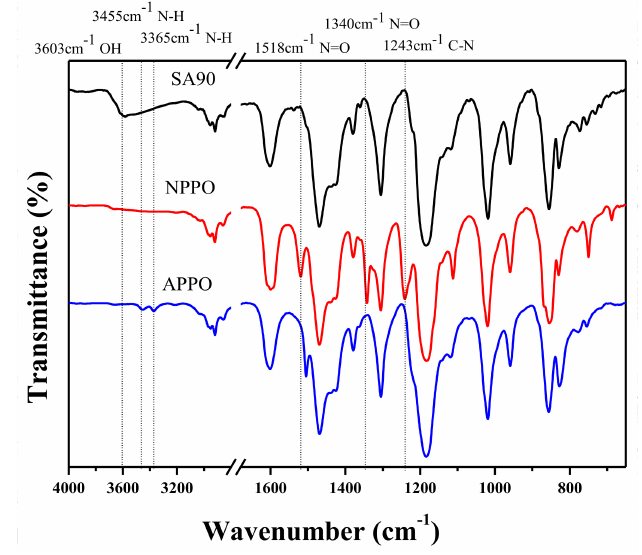
Figure 3. IR spectra of SA90, NPPO, and